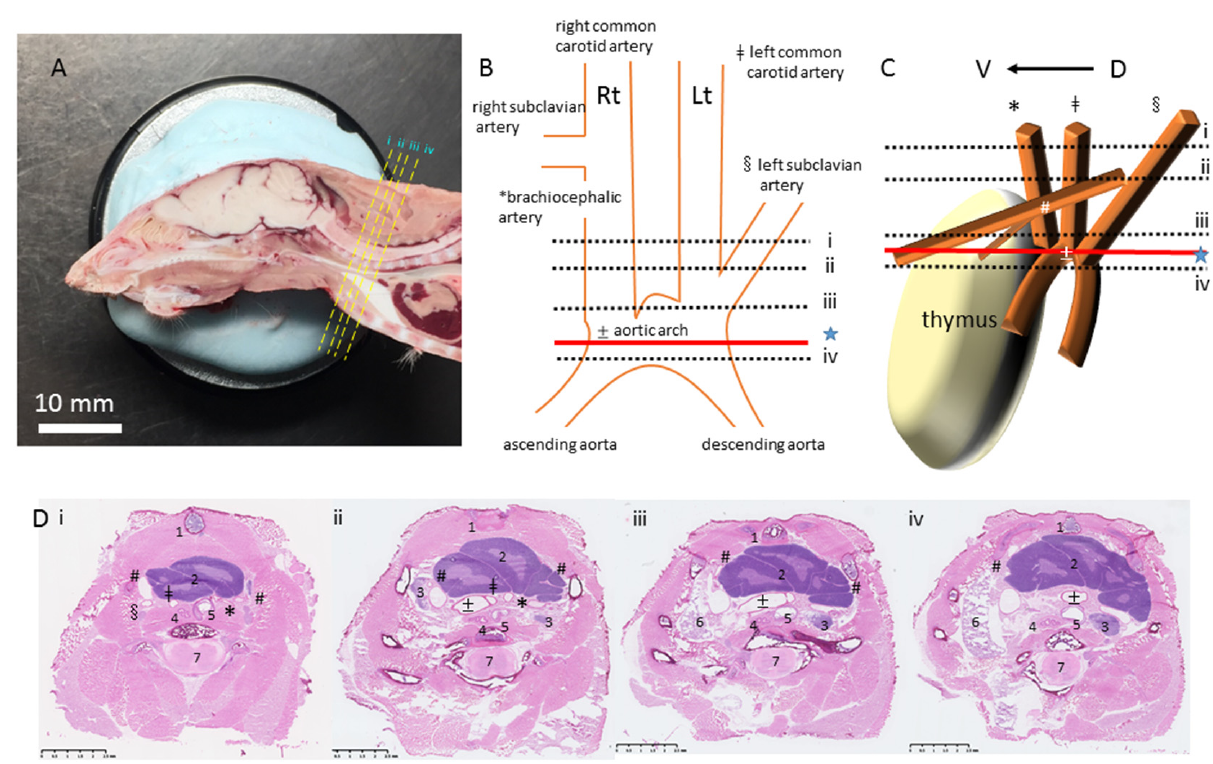
Figure 1. Orientation and structural basis of the murine thymus. ( A ) Macroscopic image of ICR mouse. Mid-sagittal section of the murine body from head to upper thorax was shown. Four yellow dotted lines, as ( i – iv ) from the cervical to the caudal orientation, show the level of the coronal sections in the upper thorax. For those tissue sections, HE staining was done in ( D ). ( B , C ) Major arterial branches are depicted in the illustrations. ( B ) ventral view, ( C ) left lateral view in 3-D mode. * Brachiocephalic artery, ‡ left common carotid artery, § left subclavian artery, ± aortic arch, # blood vessel that branch from the internal thoracic artery into the thymus. ( D ) Four coronal sections of the murine thorax. From ( i ) to ( iv ), sections were directed from head to thorax orientation. Coronal section between ( iii ) and ( iv ) was used in the following experiments. 1. Bone marrow, 2. Thymus, 3. Lymph node, 4. Esophagus, 5. Trachea, 6. Lung, 7. Spinal cord.